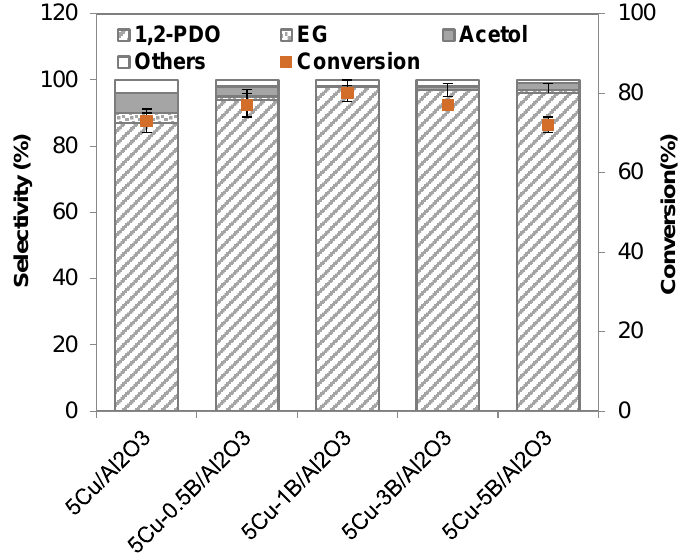
Figure 4. Influence of B loading (0–5 wt%) on 5Cu/Al 2 O 3 on activity of Cu/Al 2 O 3 catalysts for glycerol hydrogenolysis (experimental conditions: 230 °C, 6 MPa H 2 , 10 wt% aq. glycerol, WHSV 0.2 h −1 ).